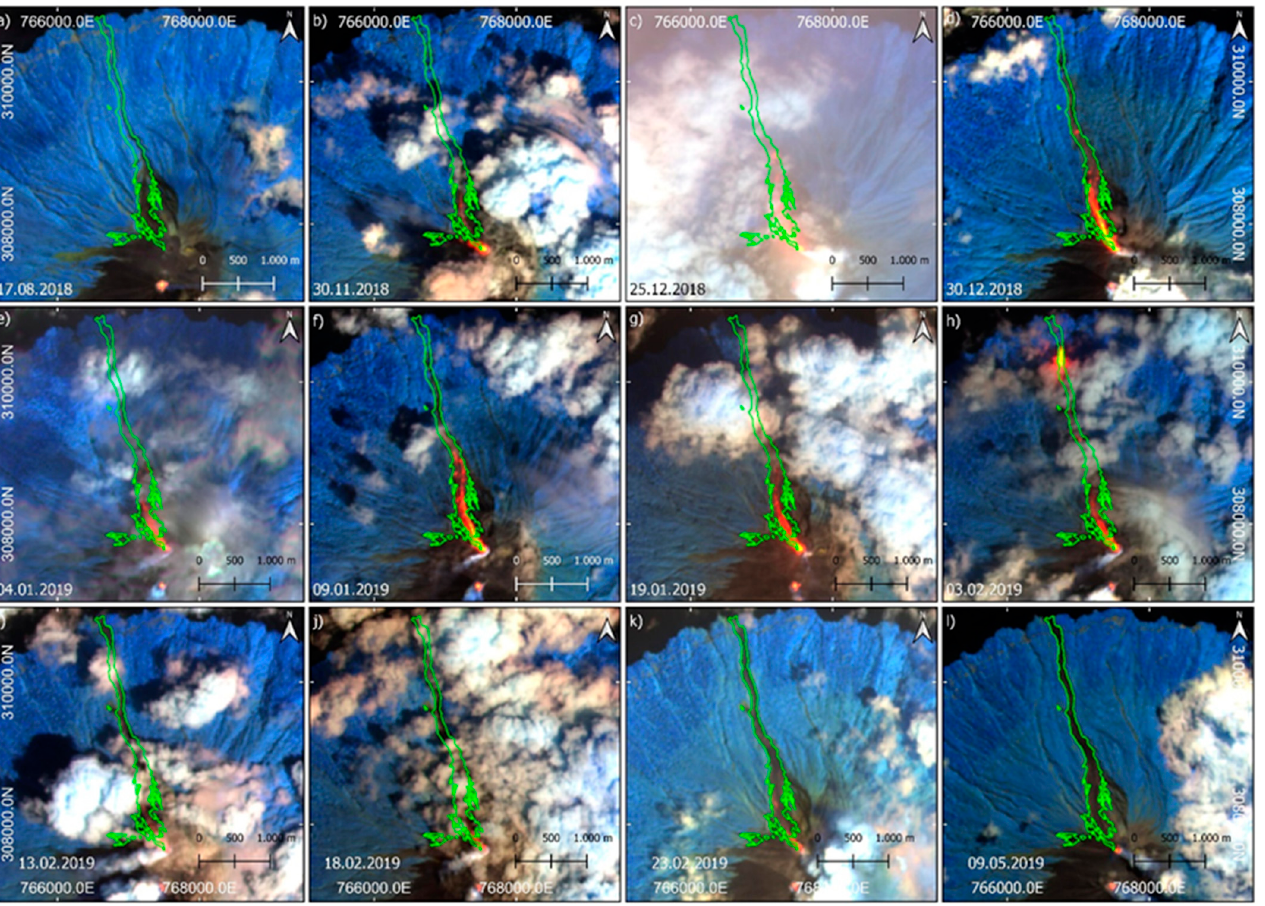
Figure 9. Multispectral false-color time series (Sentinel-2) in the SWIR2/SWIR1/NIR band combina- tion during the Karangetang I eruption period. The classified lava area (in green) outlines the thermal anomalies that occurred. ( a-l ) Volcanic activity and evolution of lava flow towards the NNW flank. Thermal anomalies of the lava flow are displayed in red to yellow, with yellower pixel indicating higher temperatures.